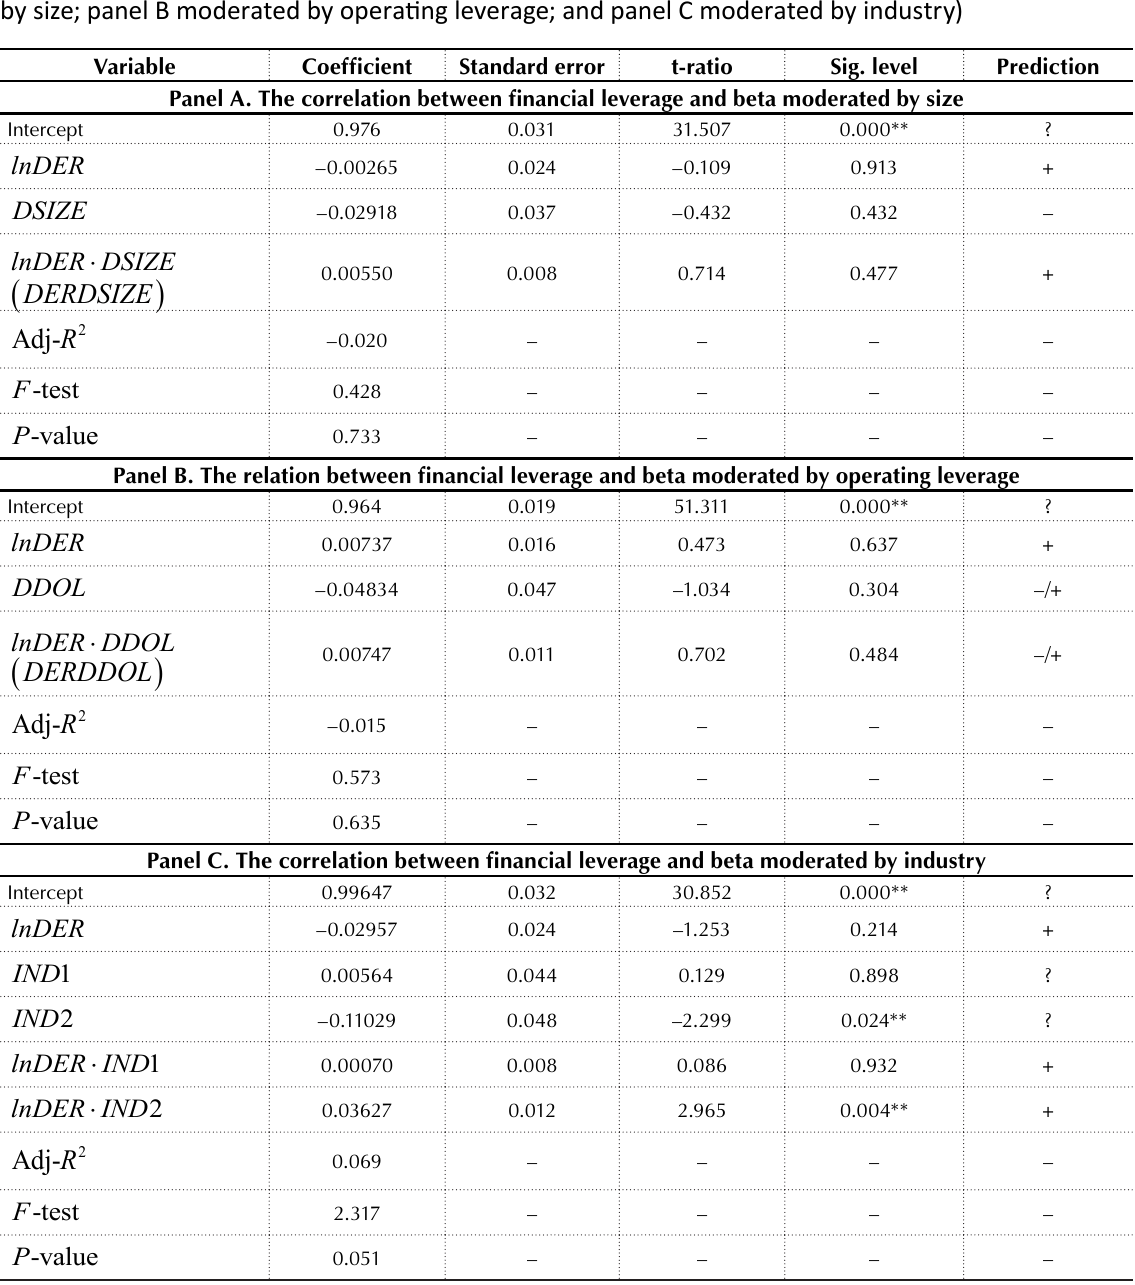
Panel C. The correlation between financial leverage and beta moderated by